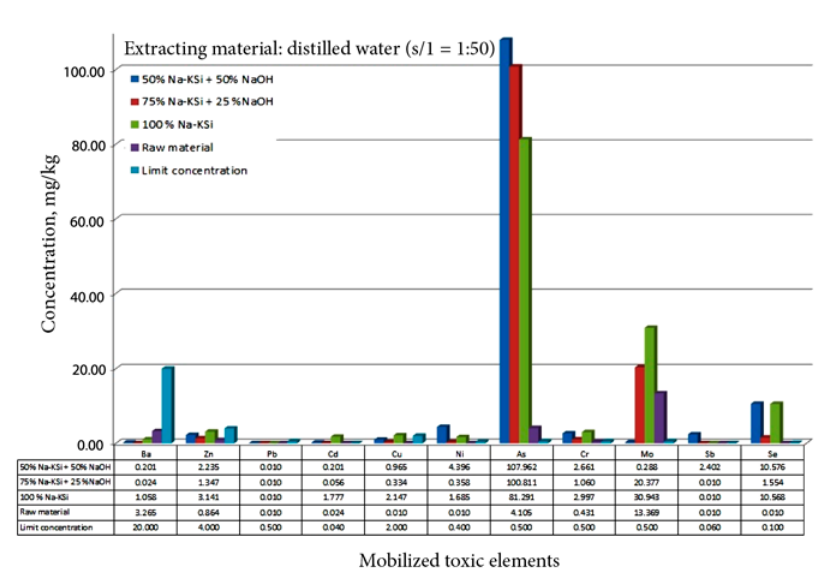
Fig. 12. Quantity of mobilized toxic elements from 120 days age geopolymers using distilled water as extracting material (solid/liquid ratio